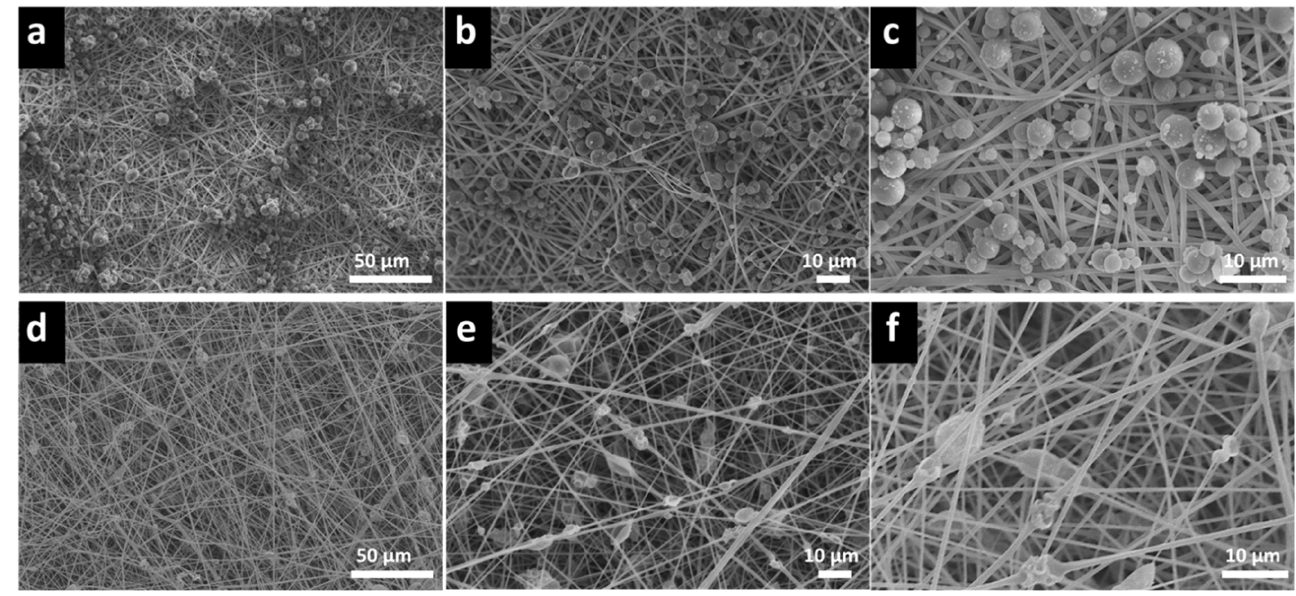
Figure 2. The SEM picture describe the incorporation of eucalyptus microcapsule within PVB nanofibers fabric. As shown in ( a ) ( × 500), ( b ) ( × 1000) and ( c ) ( × 2000), eucalyptus microcapsules are intercalated through layer-by-layer. As shown in ( d ) ( × 500), ( e ) ( × 1000) and ( f ) ( × 2000), eucalyptus microcapsules are embedded into PVB nanofibers via mixing.